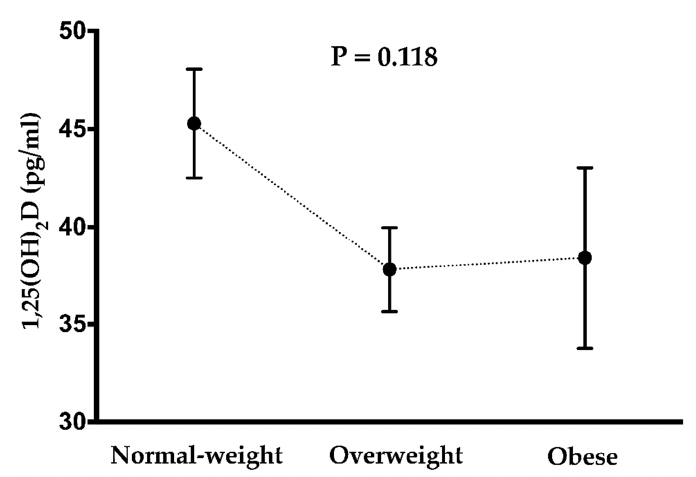
Figure 2. 1,25-Dihydroxyvitamin D (1,25(OH) 2 D) by body weight status categories in middle-aged adults. Values are presented as means and standard error. p value obtained from the analysis of the variance to compare 1,25(OH) 2 D across weight status (normal-weight, over-weight, and obese).